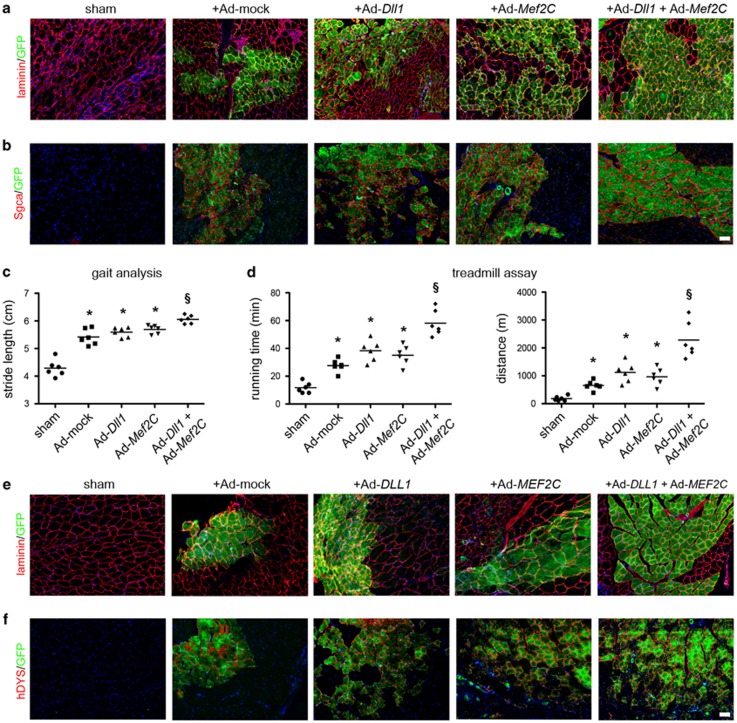
Combined priming with Dll1/DLL1 and Mef2C/MEF2C enhances the in vivo regenerative capacity of both murine and human MABs. (a, b) Immunofluorescence staining on gastrocnemius muscle slides of Sgca-null mice at 4 weeks after bilateral femoral artery injection of adenoviral-primed GFP+ murine MABs. Laminin/GFP staining (a) has been used to evaluate engraftment and Sgca/GFP staining (b) for regeneration capacity. (c, d) Functional assessment of the adenoviral-based priming on the murine MAB-driven muscle regeneration of dystrophic muscles at 4 weeks post injection. The gait analysis (c) has been performed on the stride length of mice spontaneously walking along a 1 m path. The treadmill assay (d) has been performed on mice running on a 10°-uphill oriented treadmill belt with 1 m/min2 acceleration on 10 m/min starting speed. Data points depict the value of each assayed mouse, bars indicate the average values; *P<0.05 versus sham; §P<0.05 versus Ad-Dll1 and versus Ad-Mef2C (n=6 mice/group). (e, f) Immunofluorescence staining on gastrocnemius muscle slides of Rag2-null/γc-null mice at 4 weeks after bilateral femoral artery injection of adenoviral-primed GFP+ human MABs. Laminin/GFP staining (e) has been used to evaluate engraftment and hDYSTROPHIN (hDYS)/GFP staining (f) for regeneration capacity. Sham, vehicle-injected control mice; +Ad-mock, MABs primed with Ad-LacZ, adenoviral-treated control cells with unperturbed Notch signaling. Scale bars indicate 100 μm